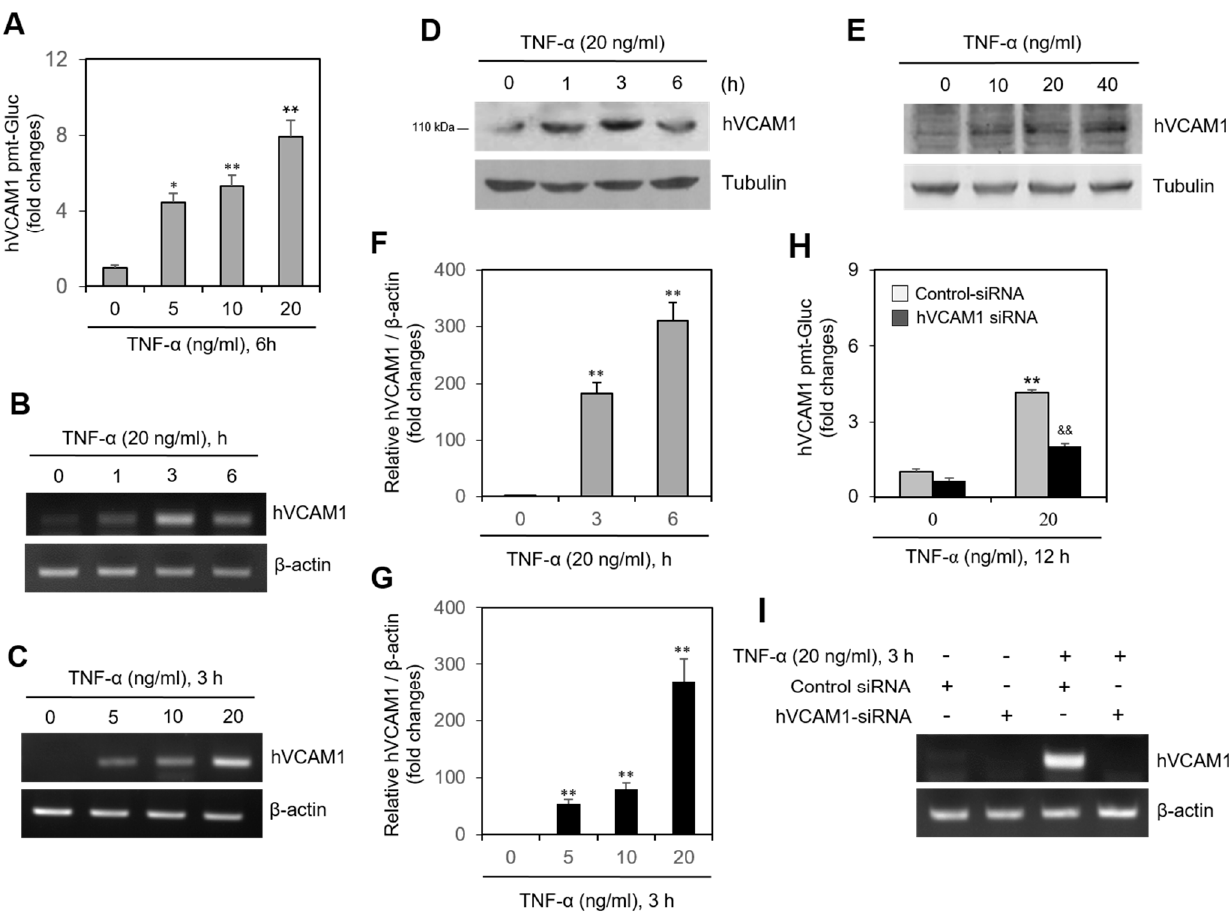
Figure 2. TNF- α increased human vascular cell adhesion molecule-1 (hVCAM1) expression. ( A ) MH7A cells were transfected with pEZx-PG02-hVCAM1-gaussia luciferase (Gluc) plasmid DNA using polyethylenimine (PEI), and treated with various concentrations of TNF- α . Gluc activity was measured by using luminometer. ( B – G ) MH7A cells treated with 20 ng/mL TNF- α for various times ( B , D , F ). hVCAM1 expression was detected by RT-PCR ( B , C ) or real-time Q-PCR ( F , G ). Cell lysates were prepared and hVCAM1 protein level was detected by western blot analysis ( D , E ). ( H , I ) MH7A cells were transfected with control or hVCAM1-siRNA to knockdown hVCAM1 expression by using Lipofectamine ® . Then, cells were transfected with pEZx-PG02-hVCAM1-Gluc plasmid DNA by using PEI, and treated with 20 ng/mL TNF- α . Gluc activity was measured by using luminometer ( H ). RNA was purified with Nucleozol ® . hVCAM1 expression was detected by RT-PCR ( I ). Each experiment was performed at least four times. Data in a bar graphs represent the means ± SD. * p < 0.05, ** p < 0.01; significantly different from TNF- α -untreated ( A , F , G ). or control siRNA-treated and TNF- α -untreated ( H ) control group. && p < 0.01; significantly different from control siRNA-treated and TNF- α -treated control group ( H